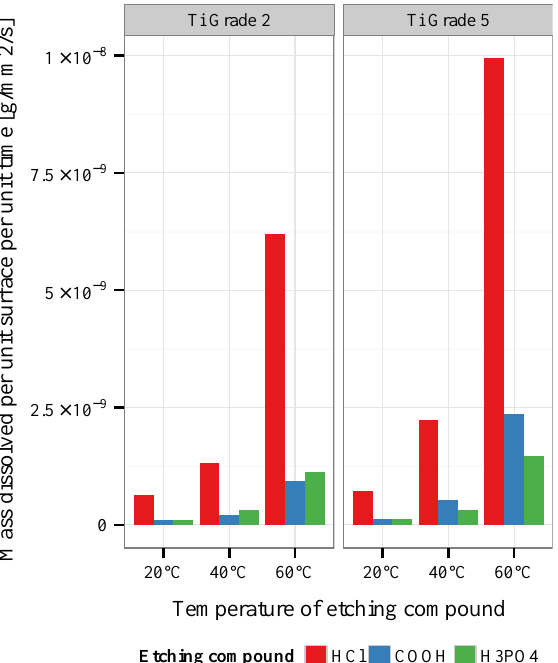
Figure 4. Mass dissolution per unit time of Ti grade 2 and Ti grade 5 in each etching